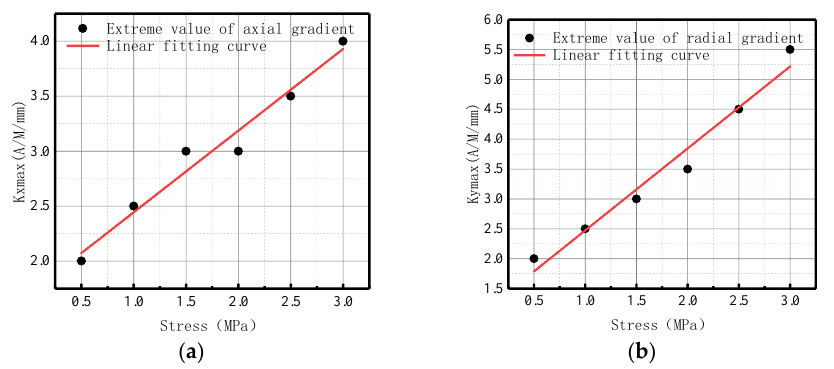
Figure 38. Variations of Kmax at the crack of base metal under different internal pressures. ( a ) Axial component of Kmax ; ( b ) radial component of Kmax .